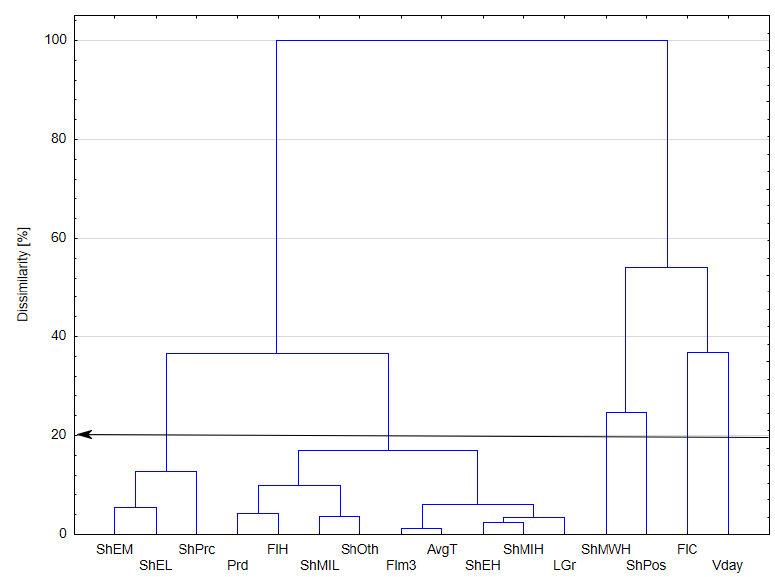
Figure 3. Dendrogram of variables for machine B.